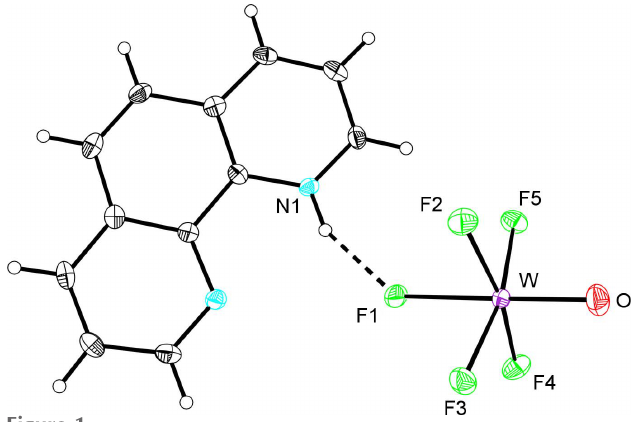
Figure 1 Displacement ellipsoid plot (50% probability level) of (1,10-phen- H)[WOF 5